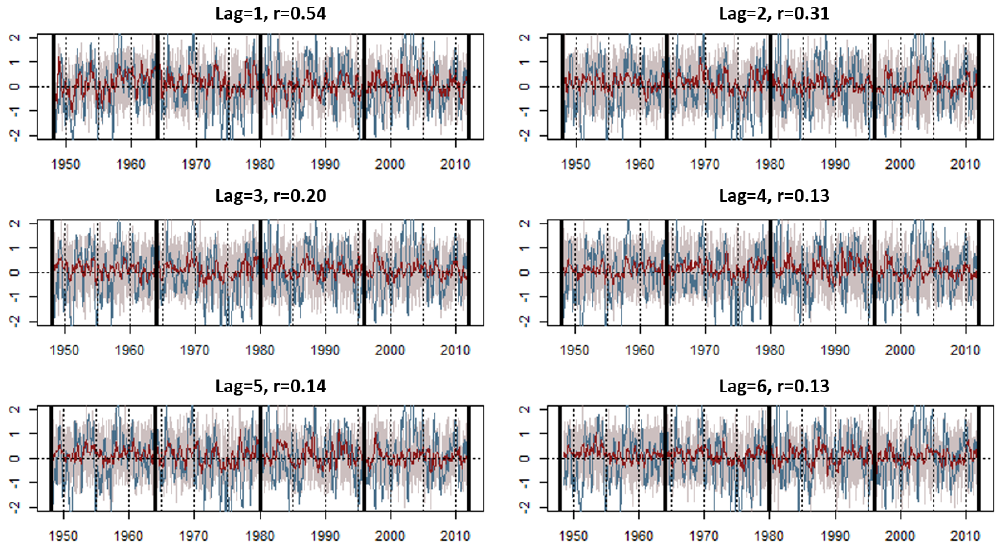
Figure 4. Time series of observed (blue line) and forecasted (red line) running 3-month SPI values for the northern central Asia. The shaded areas indicate the 3-month total of maximum and minimum forecasts of single trees of the random forest model. Black verticals indicate the division of the time series into four independent evaluation